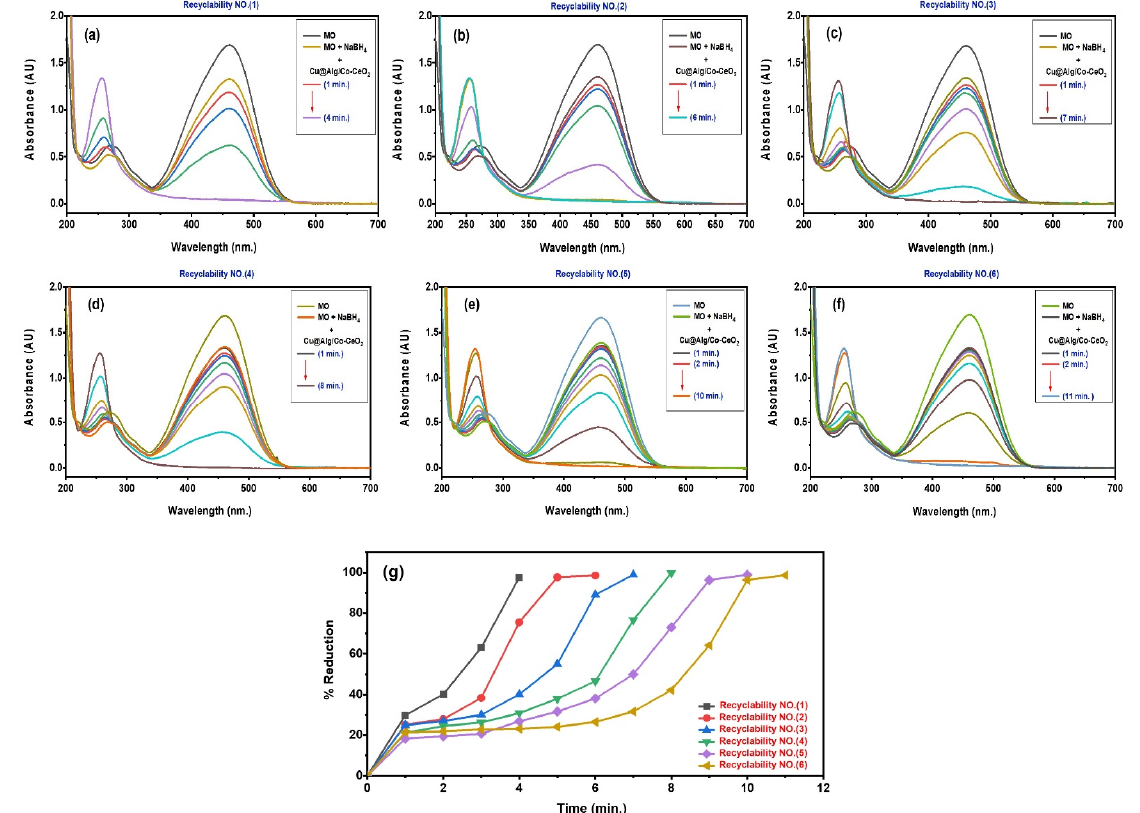
Figure 7. UV–vis absorption spectra for the reduction of MO (0.07 mM) using 0.5 mL NaBH 4 (0.1 M) and Cu@Alg/Co–CeO 2 catalyst (6 beads): ( a ) 1st cycle, ( b ) 2nd cycle, ( c ) 3rd cycle, ( d ) 4th cycle, ( e )